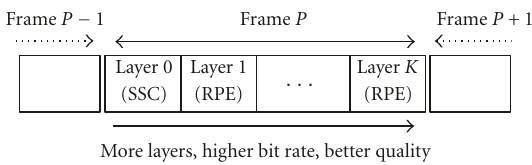
Figure 11: SSC-ERPE frame suitable for variable rate